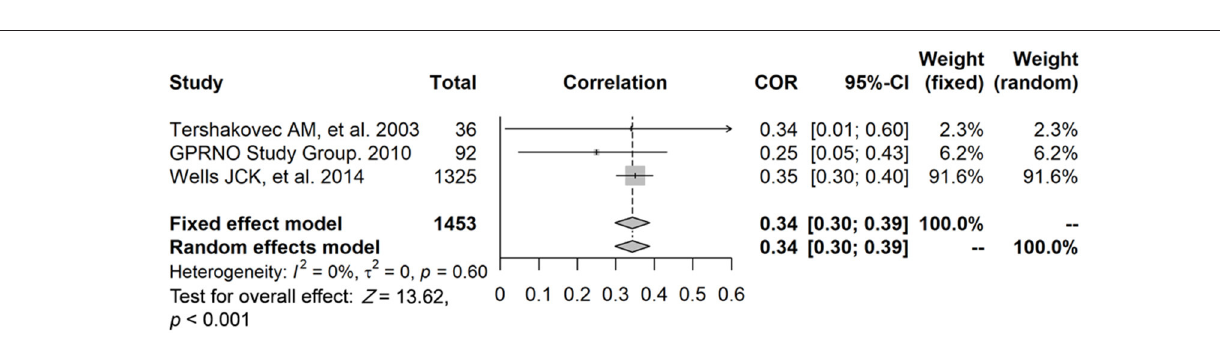
FIGURE 4 | The relationship between FFM and fasting plasma insulin